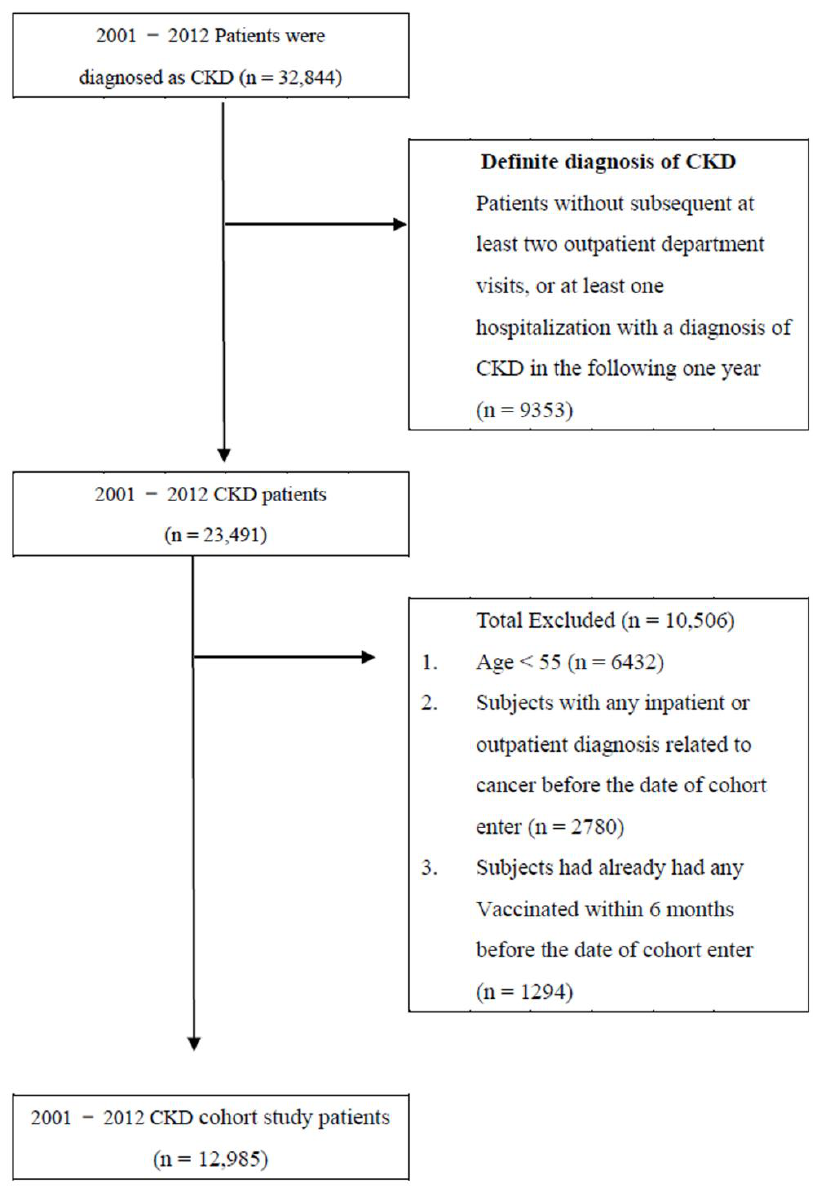
Figure 1. Data selection